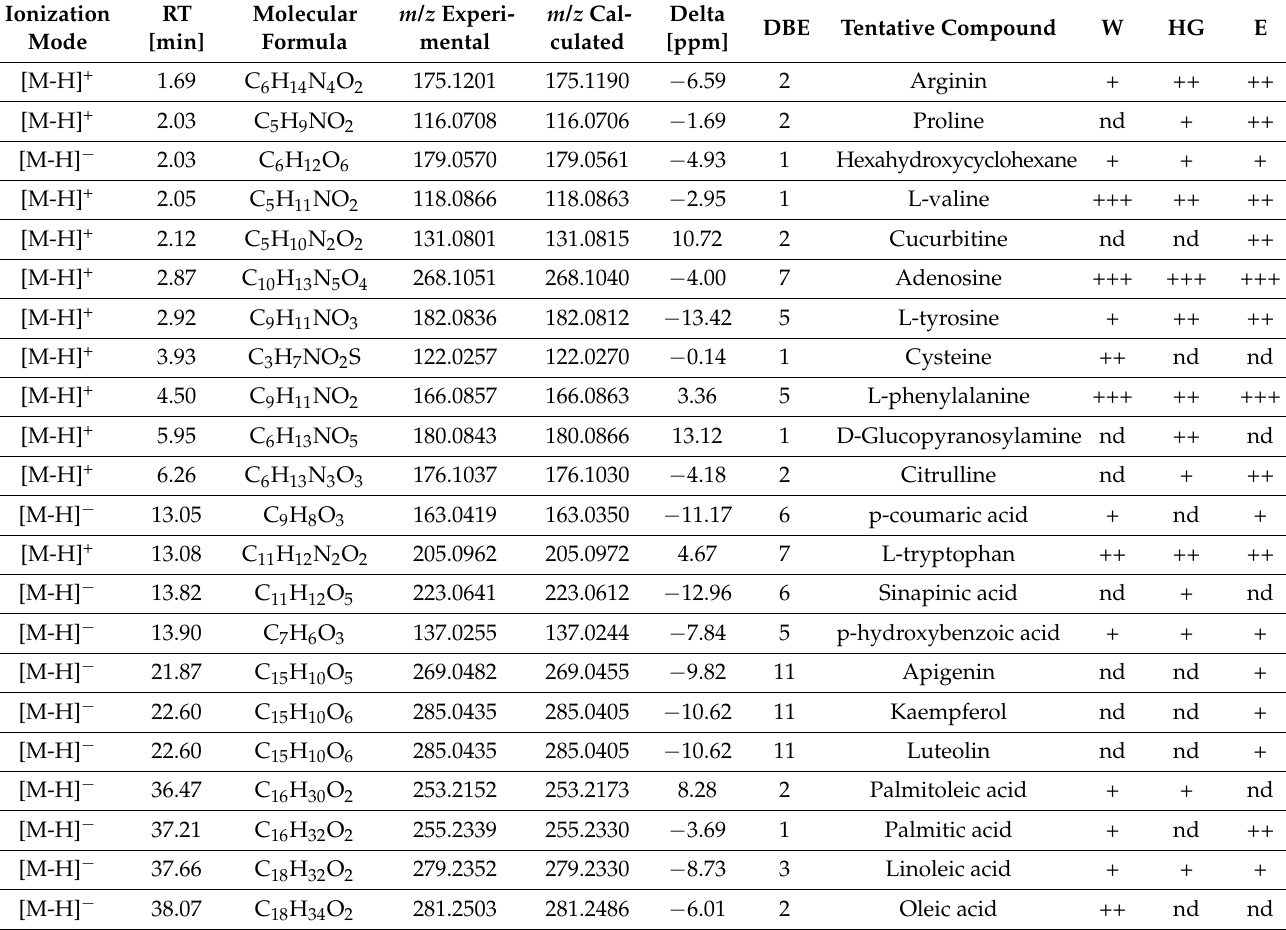
Table 4. The tentatively identified compounds in C. moschata ‘Butternut’ peel